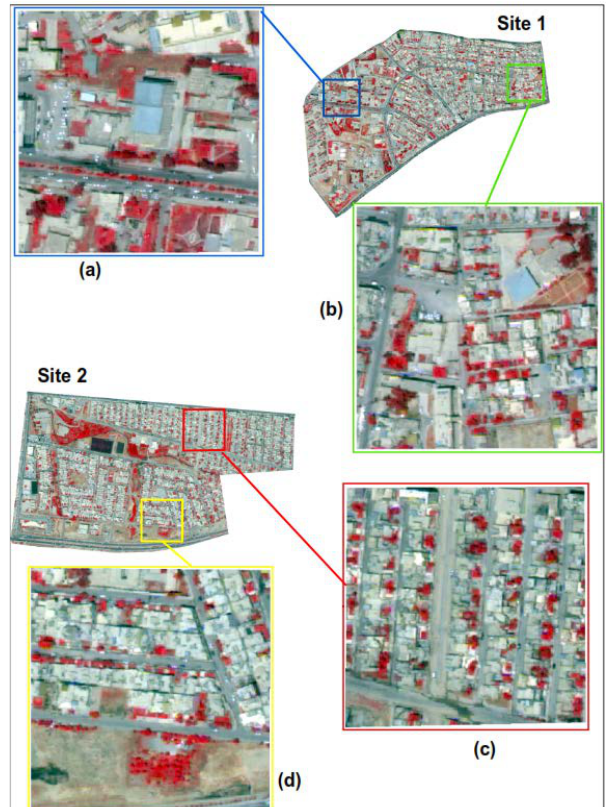
Figure 2: Four VHR samples from both sites: (a) Sample 1 (SP01) spared trees with grass land, (b) Sample 2 (SP02) low dense tree crowns without grass land, (c) Sample 3 (SP03) individual tree crowns, (d) Sample 4 (SP04) low dense tree